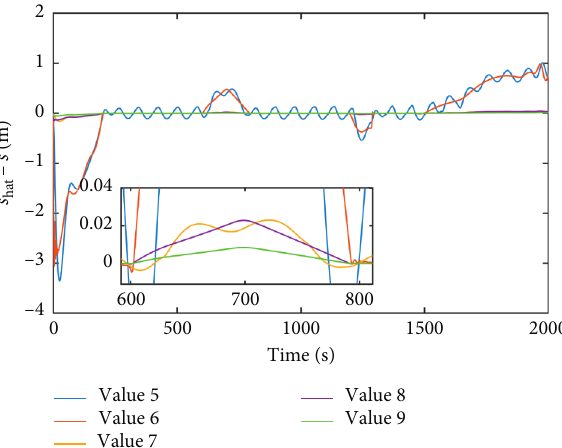
Figure 6: Velocity observer estimation error of the HST.